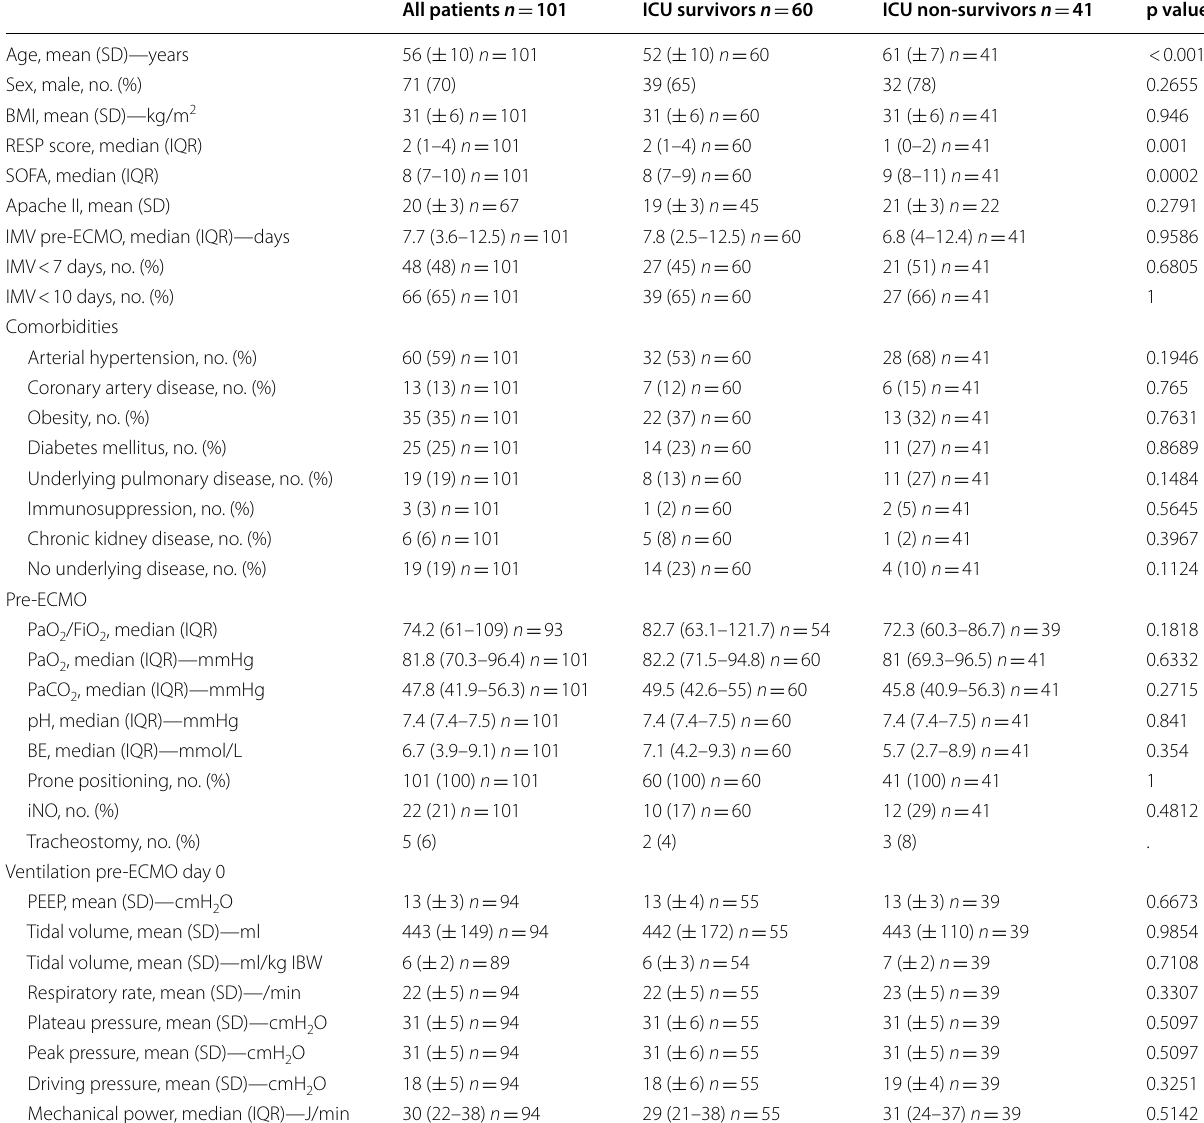
Table 1 Demographic data and baseline characteristics, ventilation parameters before ECMO day